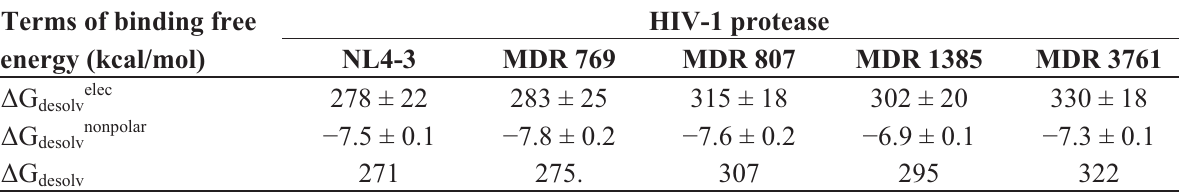
Table 4. Energy analysis of the HIV-1 protease-CA/p2